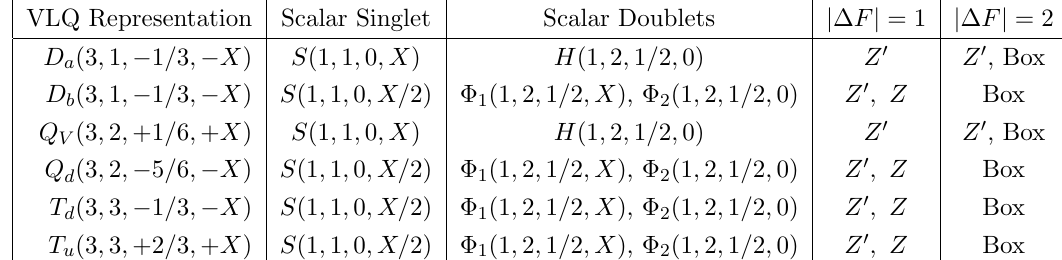
Table 1. Fermion and scalar representations under SU(3) c models. In the last two columns we show which diagrams dominate NP contributions to and (cid:1) F = 2 transitions for M j j